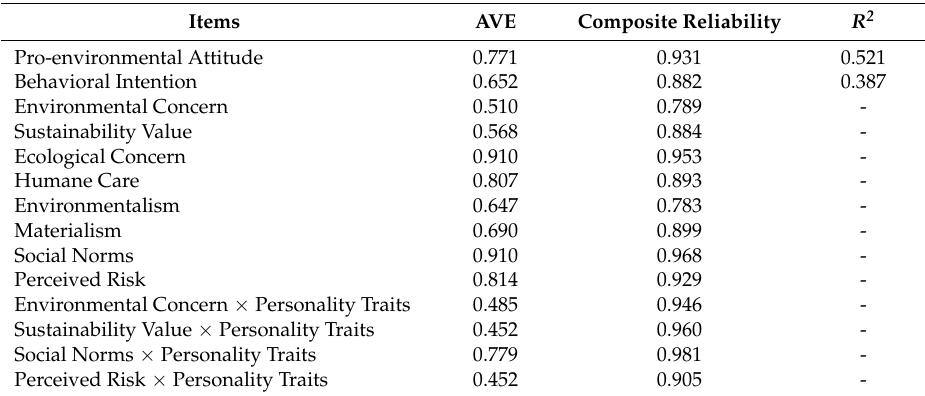
Table 2. Reliability and validity indicators of the proposed